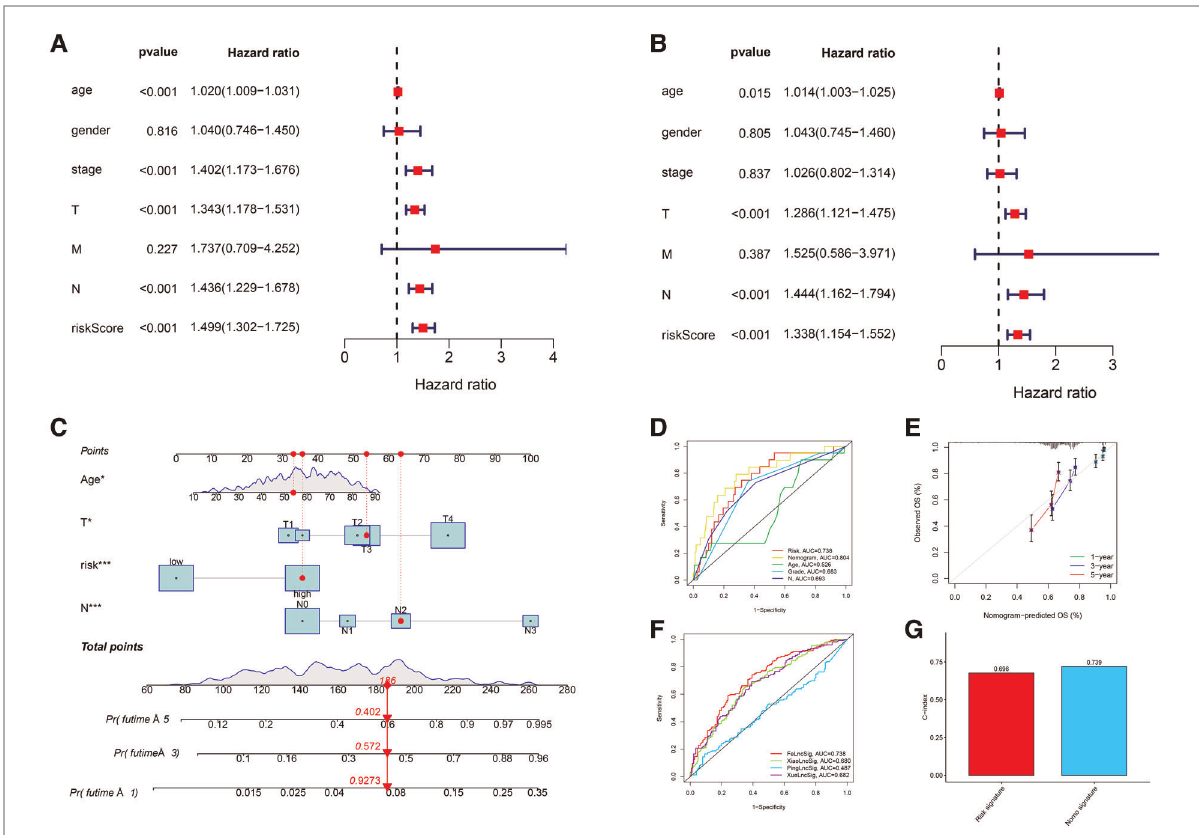
FIGURE 4 Independent prognostic value of the lncRNA signature and the comprehensive nomogram. ( A ) Univariate Cox regression identi fi ed individual factors related to OS. ( B ) Multivariate Cox regression identi fi ed independent predictors of OS. Our lncRNA signature was an independent predictor of OS with a hazard ratio of 1.338 (95% CI, 1.154-1.552, P <.001). ( C ) The nomogram including the lncRNA signature, age, T stage, and N stage for the practical prediction of the prognosis of CM patients. ( D ) AUCs of nomogram, signature and other clinicopathological characteristics for predicting 3-year OS. ( E ) A calibration curve analysis showed that the nomogram predictions were consistent with actual observations. ( F ) The ROC comparison of the studied signature with existing signatures. ( G ) The C-index of